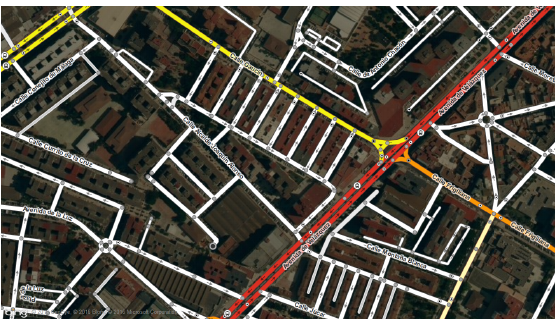
Figure 2. Digital map with graph